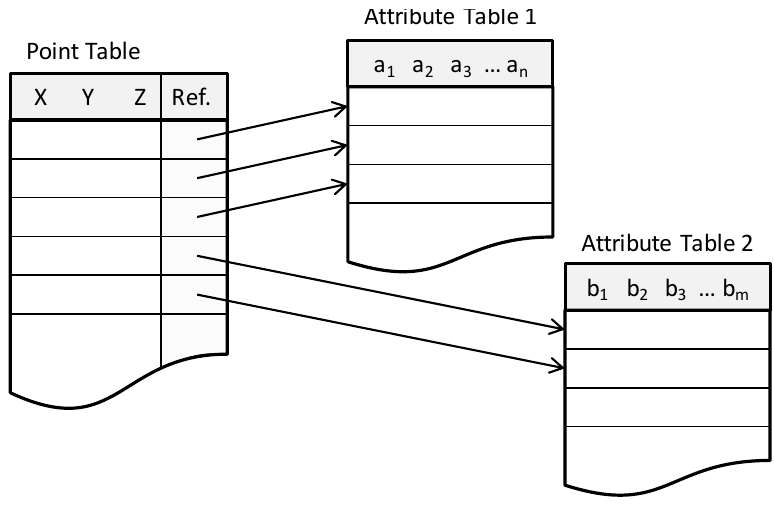
Figure 4. Relation of separated point and attribute structures.